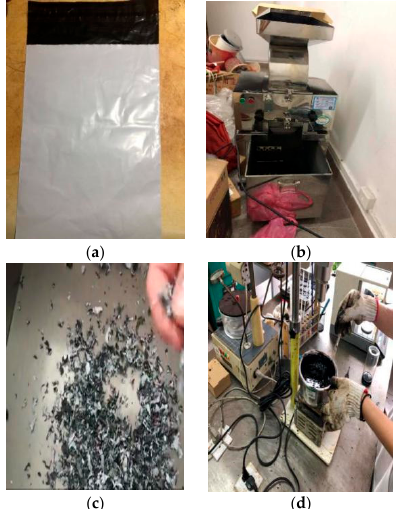
Figure 1. Preparation of the wasted express bag (WEB)-modified bitumen. ( a ) wasted express bags; ( b ) grinding machine; ( c ) wasted express bags (after grinding); ( d ) modification process.